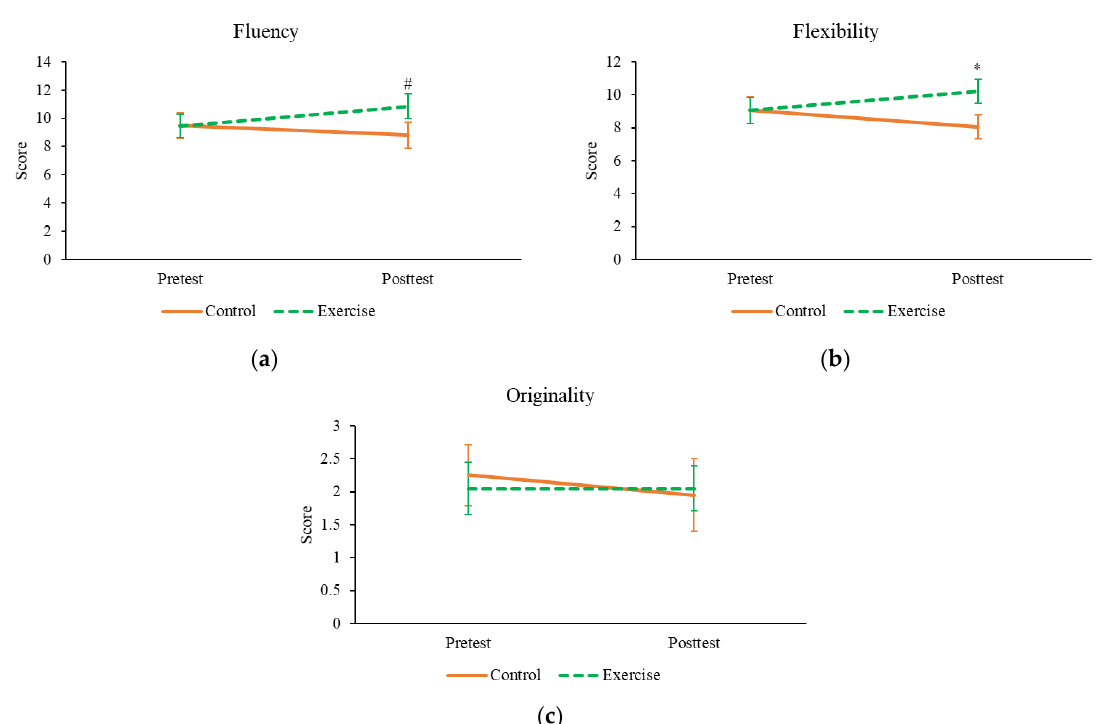
Figure 3. Exercise effect on divergent thinking (AUT). ( a ), fluency; ( b ), flexibility; ( c ), originality. * p < 0.05, indicating a significant effect of group × time interaction; #, p = 0.066 for the group × time interaction. Data shown as means ± SE.